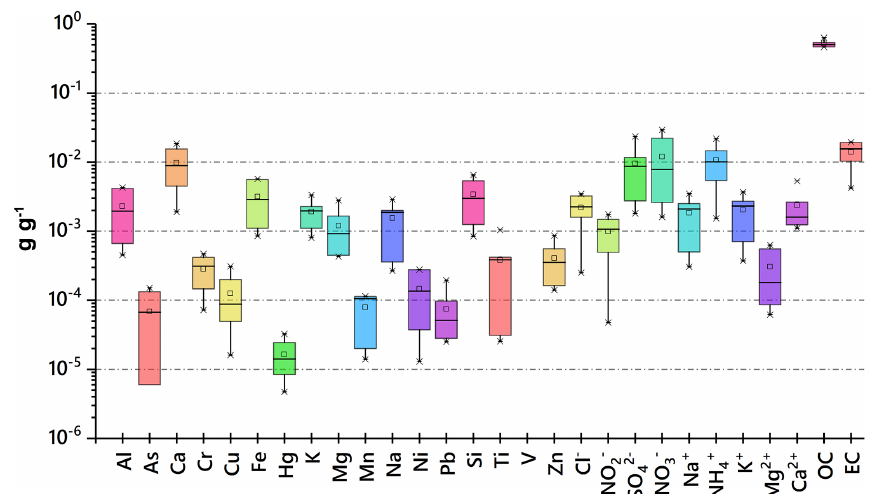
Figure 13. PM 2 . 5 chemical profiles of cooking emissions. Data were collated from the Nankai University source library, Zhang et al. (2017a), See et al. (2006), and Taner et al.